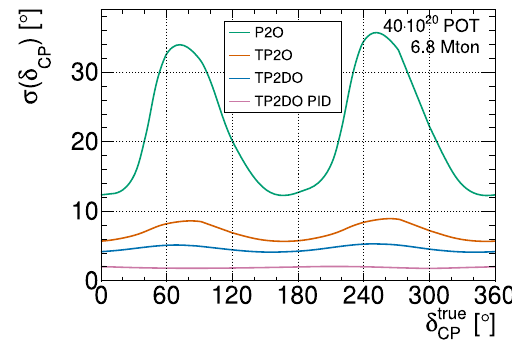
Fig. 9 Precision on δ CP as a function of the true δ CP value for P2O (green), tagged P2O (red), tagged P2O with a far detector with a pho- tocathode density twice as large as KM3NeT/ORCA (blue), and with a perfect PID